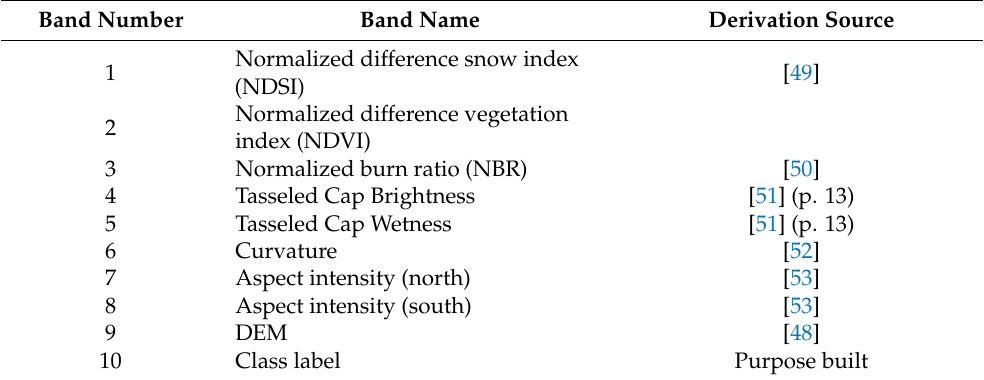
Table 1. Summary of optical (1–5) and topographic (6–9) predictors used for the spatiotemporal exploratory model (STEM) and GlacierCoverNet